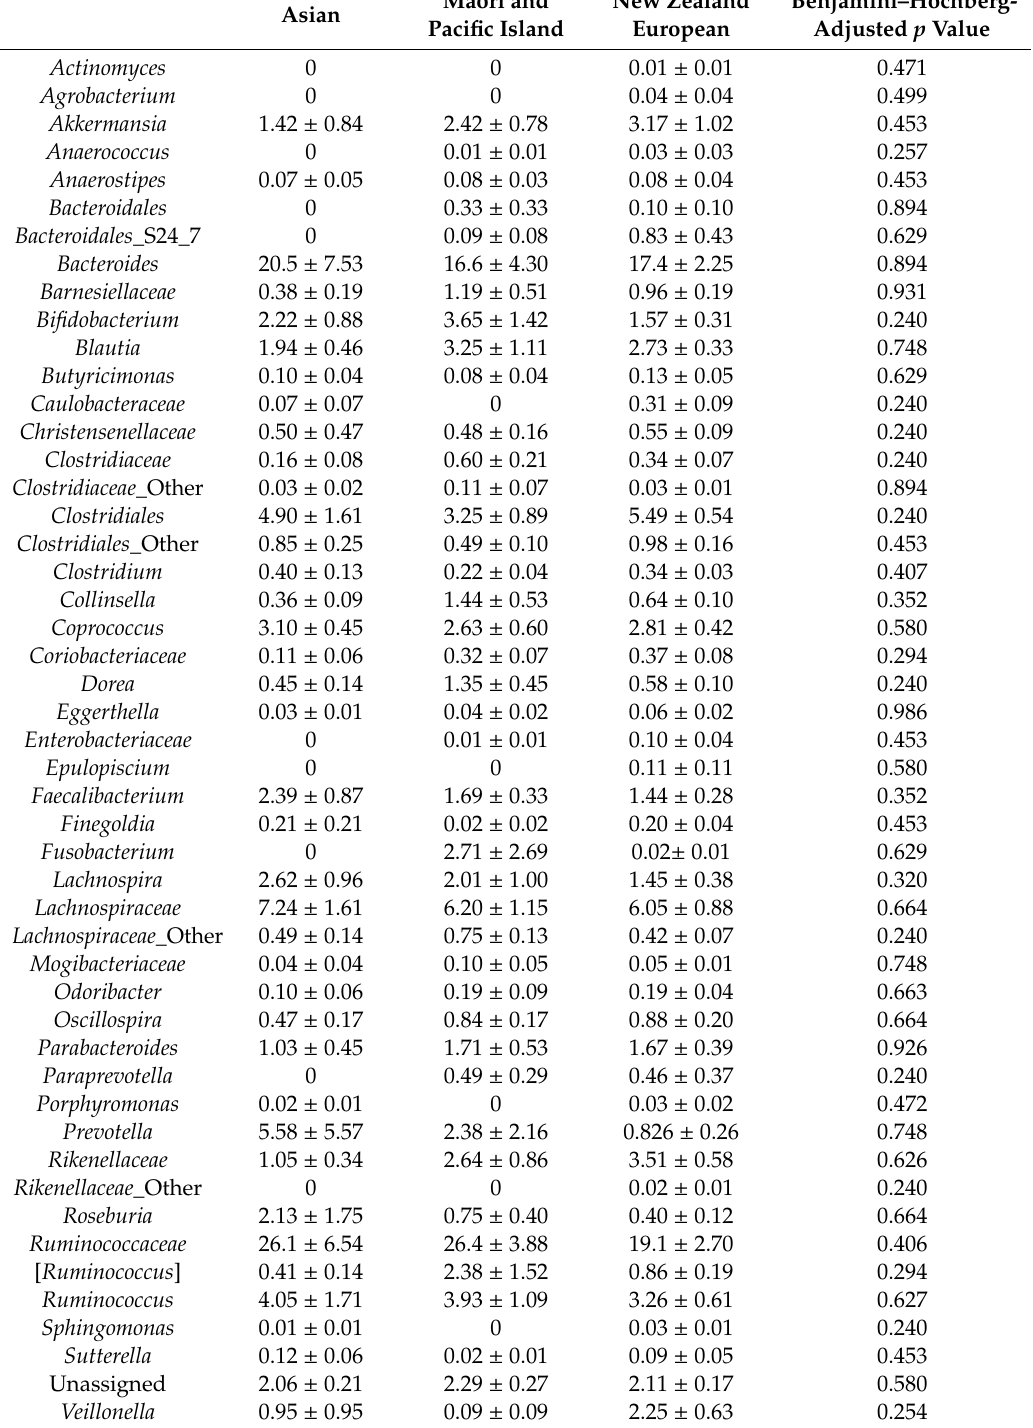
Table 2. Relative abundance of bacteria at the genus level in the mother’s feces categorized according to the